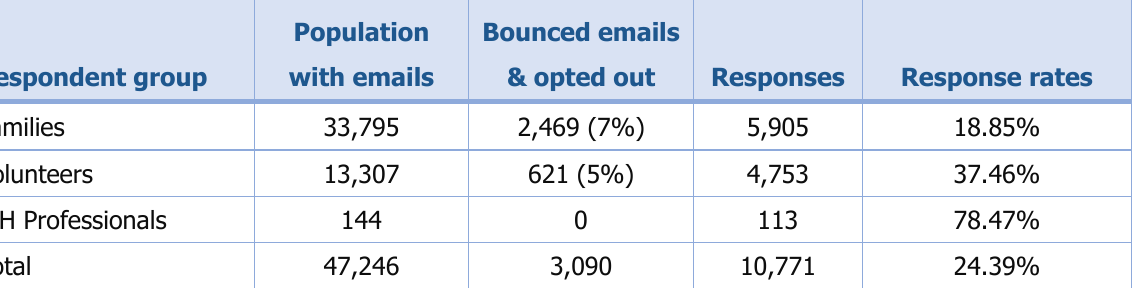
Table 2. Survey Response